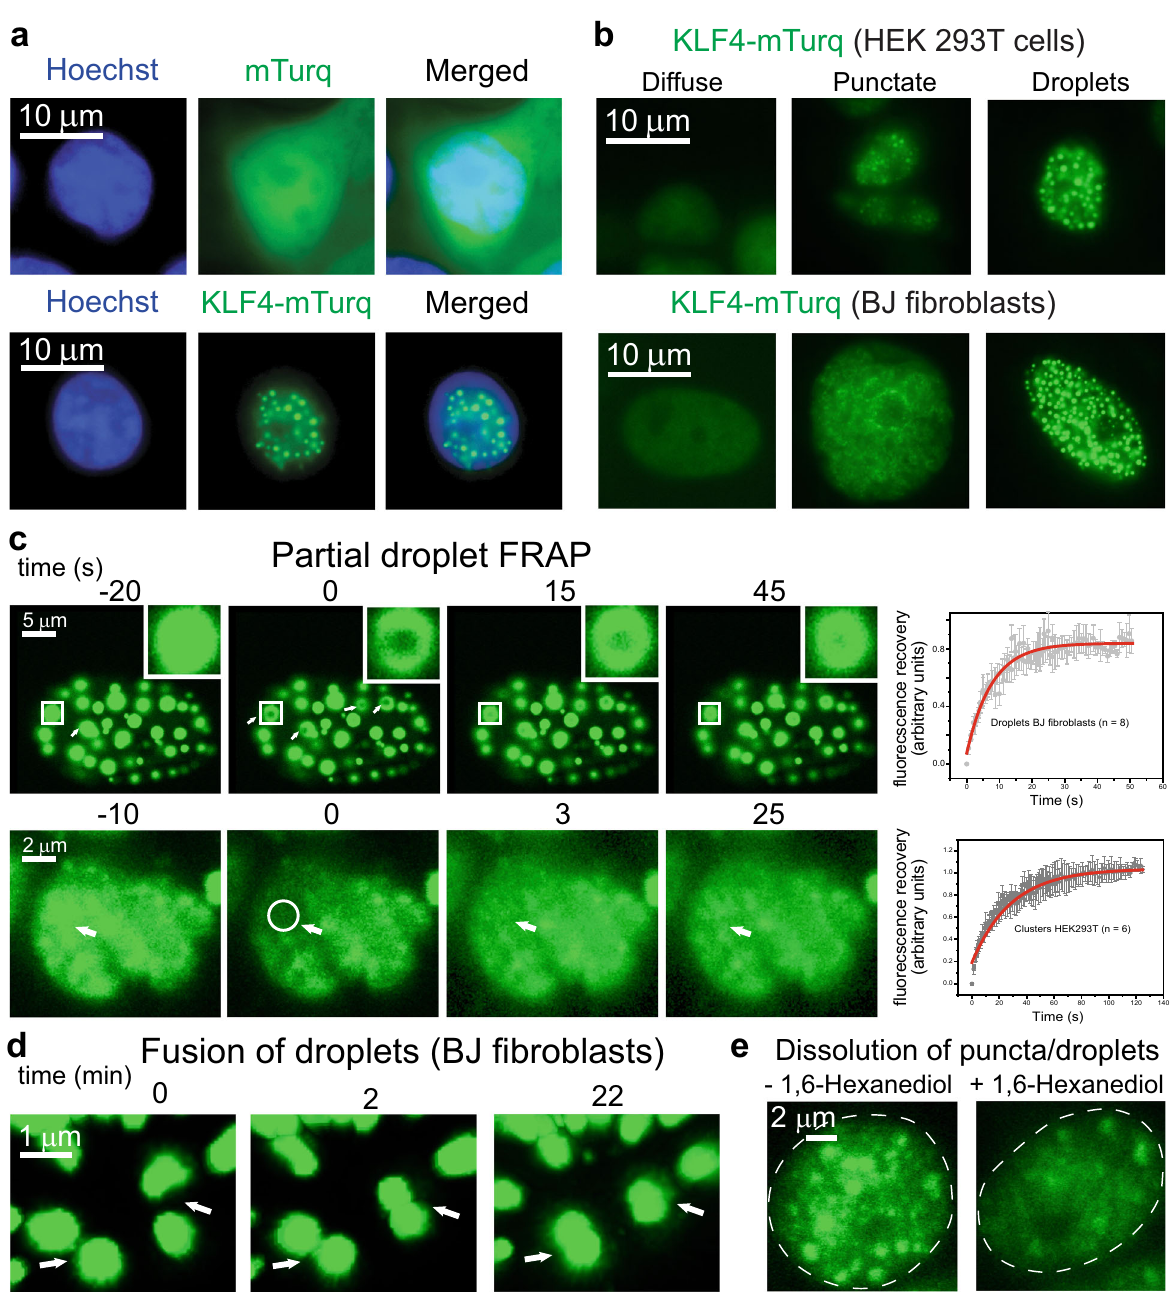
Fig. 1 KLF4 forms a condensed liquid phase in HEK 293T cells and BJ fi broblasts. a Fluorescence microscopy images of DNA (Hoechst), mTurq fl uorescent tag (top), and KLF4-mTurq (bottom) in HEK 293T cells. Nuclear mTurq distribution is diffuse whereas KLF4-mTurq forms biomolecular condensates. Similar results were obtained for >5 biological replicates. b HEK 293T cells (top) and BJ fi broblasts (bottom) expressing KLF4-mTurq exhibit diffuse distribution (left), irregular puncta (middle), or droplets (right; circularity > 0.8). Similar results were obtained for 3 biological replicates. c Fluorescence recovery after photobleaching (FRAP) of KLF4-mTurq droplets in BJ fi broblasts (top row) bleached at positions indicated by white arrows; right panel is a recovery curve ( n = 8 droplets) and enlarged insets track one droplet (white square). FRAP of KLF4-mTurq puncta in HEK 293T cells (bottom row) bleached at positions indicated by white arrows and circle; right panel is a recovery curve ( n = 6 punctate fi elds). Data are presented as mean values ± SD. d Fluorescence image time course of droplet fusion (at white arrows) in BJ fi broblasts. Fusion was veri fi ed with 3D z-stack images. e Fluorescence microscopy image of KLF4-mTurq puncta and droplets in HEK 293T cells before (left) and after (right) 1,6-hexanediol treatment. Nucleus outline in white dashes. Similar results were obtained for 2 biological DBD:NANK LLPS depends in complex ways on the compo- above LLPS is no longer detected (Fig. 2h). The lack of LLPS at nent concentrations. At 6 µM DBD, 0.25 µM NANK induces high NANK suggests that phase separation requires a minimum readily detectable LLPS, and increasing NANK up to 1 µM DBD:NANK ratio, perhaps to saturate NANK cognate KLF4 sites. increases the amount of condensate, but further increases in At any given DBD concentration, LLPS is not observed below a NANK actually produce less condensate, and at 3 µM NANK and threshold NANK concentration; this NANK threshold is lower at